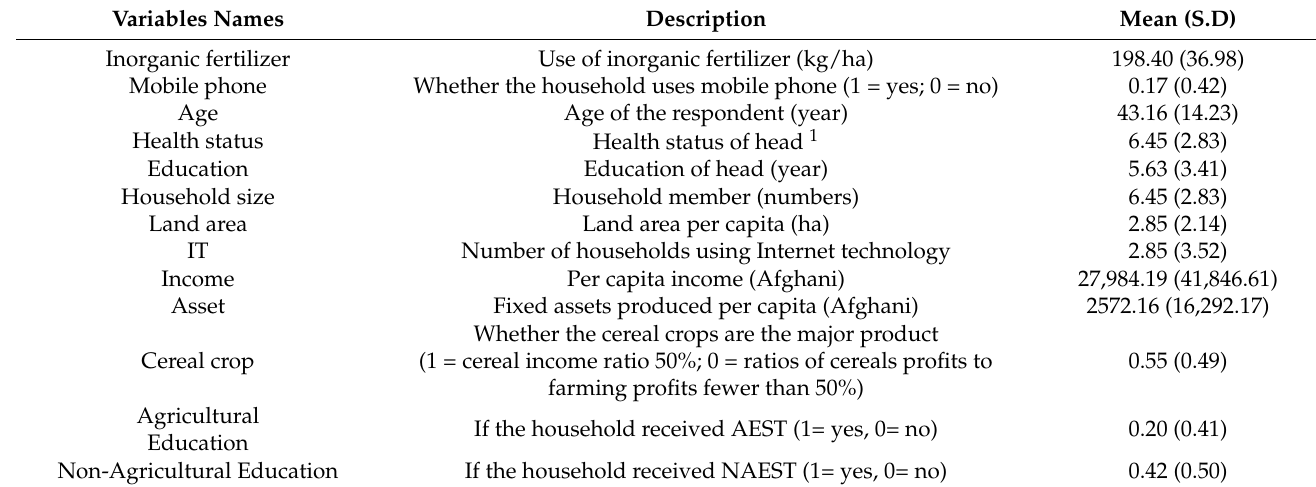
Table 1. Variables’ description and descriptive